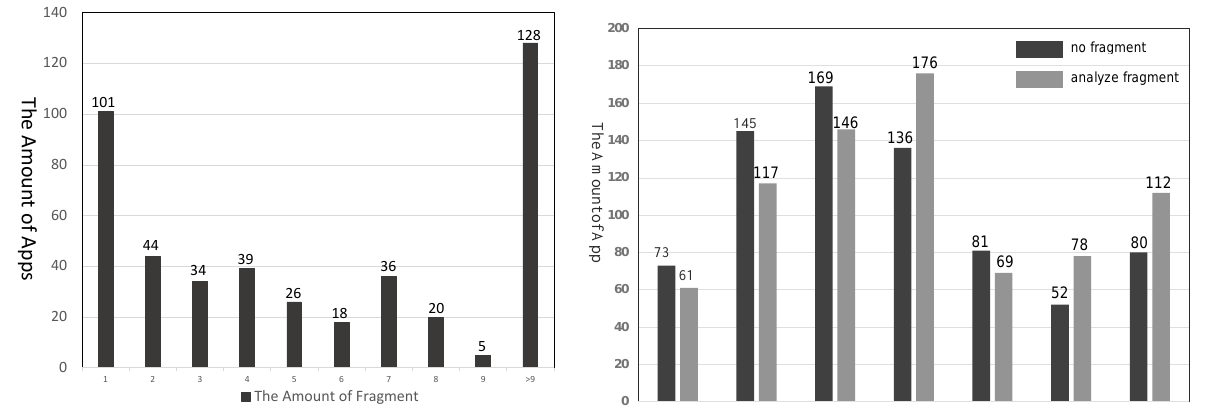
Figure 9. Distribution of The Number of Fragments for Popular Apps